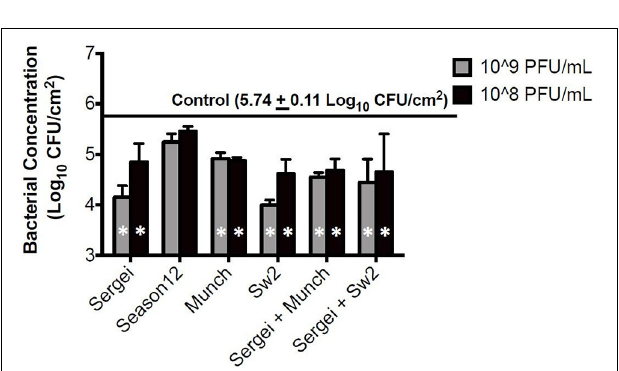
FIGURE 3 | Bacterial survival after phage treatments in the cattle hide model. Bars indicate bacterial survival after 1 h phage treatment. Bar shading indicates two phage treatment concentrations at 10 8 and 10 9 PFU/mL, and the solid line parallel to the X -axis indicates the bacterial load in the positive (no phage) control. Error bars indicate standard deviation across three biological replicates. White stars in the bars represent significant difference in the treatment from the positive control. The detection limit of this assay is 1.15 log 10 CFU/cm 2